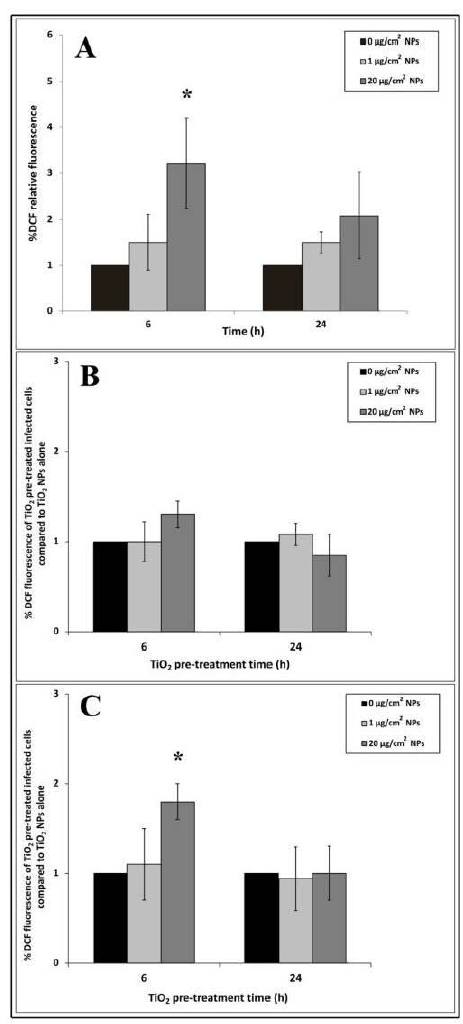
Figure 5. Reactive oxygen species (ROS) measurements in HT-29 cells pre-treated with TiO 2 NPs alone and following EGD-e infection. ( A ): TiO 2 NPs alone. ( B ): 3 h of EGD-e infection. ( C ): 24 h of EGD-e infection. Values are expressed as a percentage of the control samples (taken as 1%) with means ± SD calculated from three independent experiments. Asterisks denote statistically significant values compared to control untreated cells for Panel A and control NP untreated infected cells for Panels B and C (* p < 0.05).